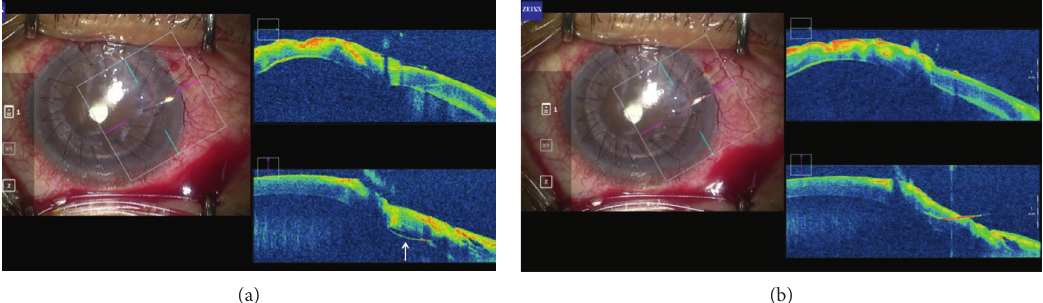
Figure 1: MIOCT images of the graft suture. (a) Needle penetration. When the 10-0 nylon needle was threaded through the graft, needle penetration was suspected based on the surgeon’s judgment using his/her hand. MIOCTclearly showed that the needle penetrated and was located under the corneal endothelium (arrow). (b) MIOCT image after the corneal resuture. Once the needle is removed and the graft is restitched, the needle is threaded deep into the cornea